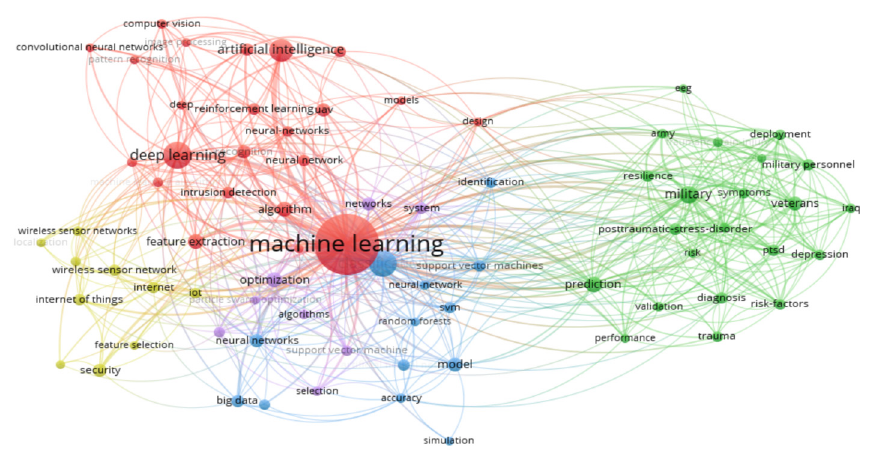
Figure 6. Preliminary network by co-occurrence.